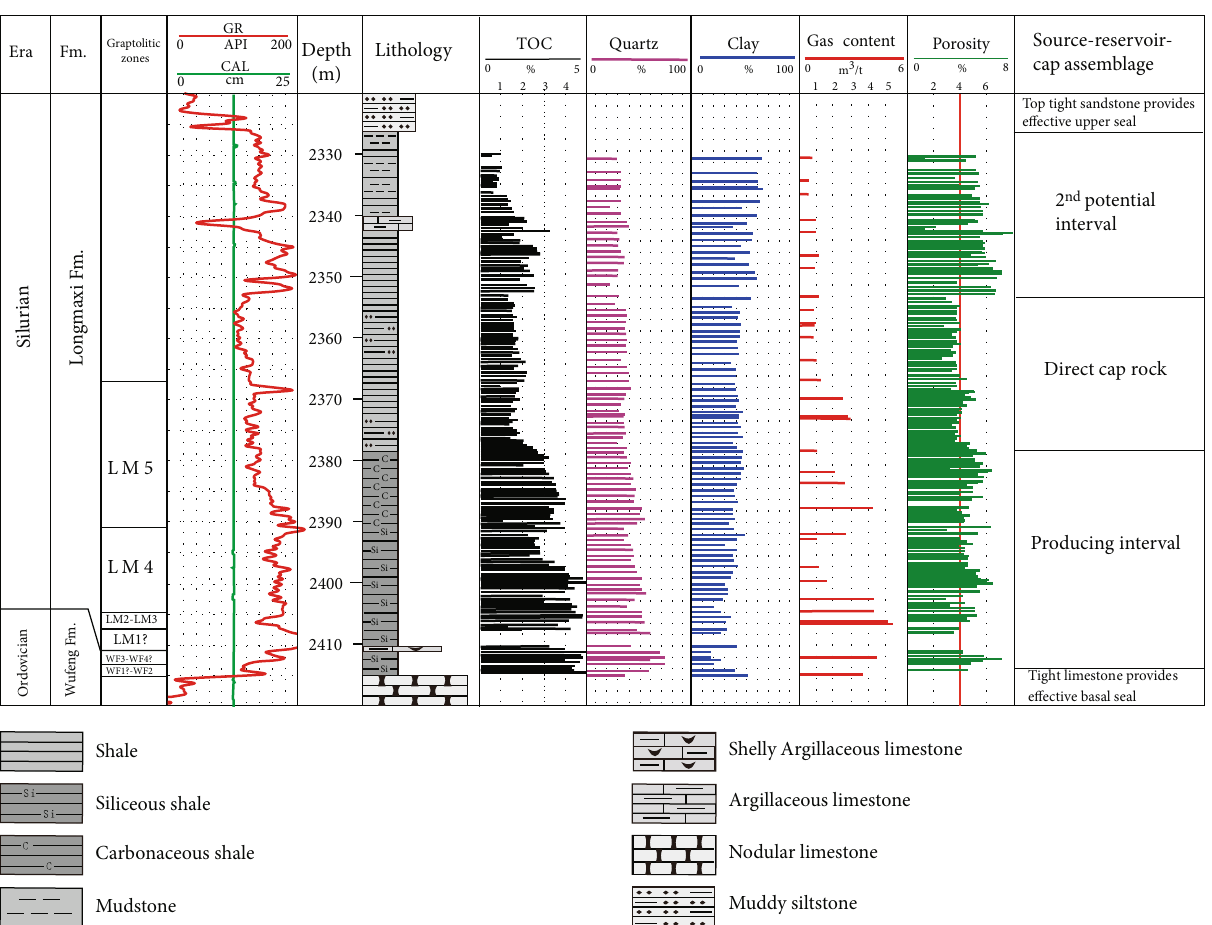
Figure 4: Comprehensive evaluation histogram showing favorable interval for shale gas exploration in JY 1 Well (modi fi ed from [20]) with the upper boundary of the producing interval in the middle of the LM5 GZ. The mineral composition is obtained by X-ray di ff raction, and the gas content is based on on-site desorption of